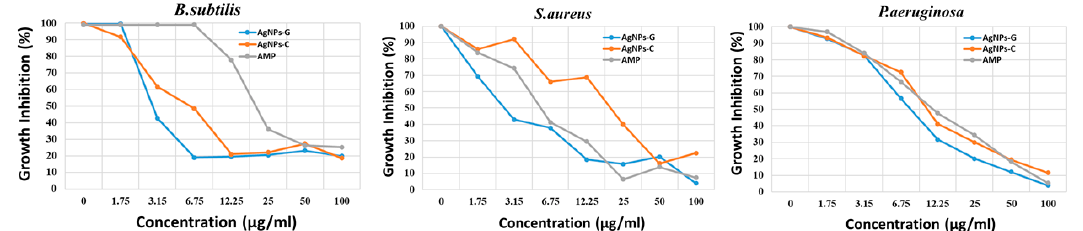
Figure 6. Antimicrobial activity of B.subtilis , S.aureus and P.aeruginosa by MIC 50 method for AgNPs-G in comparison to AgNPs-C and ampicillin (AMP).